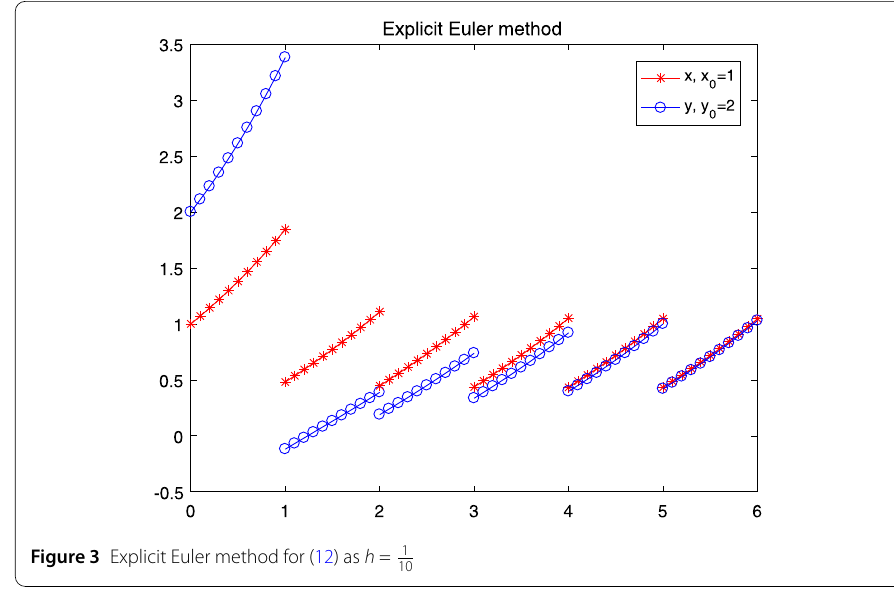
Figure 3 Explicit Euler method for (12) as h = 1